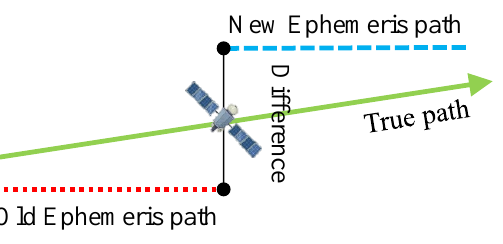
Figure 2. Schematic diagram of